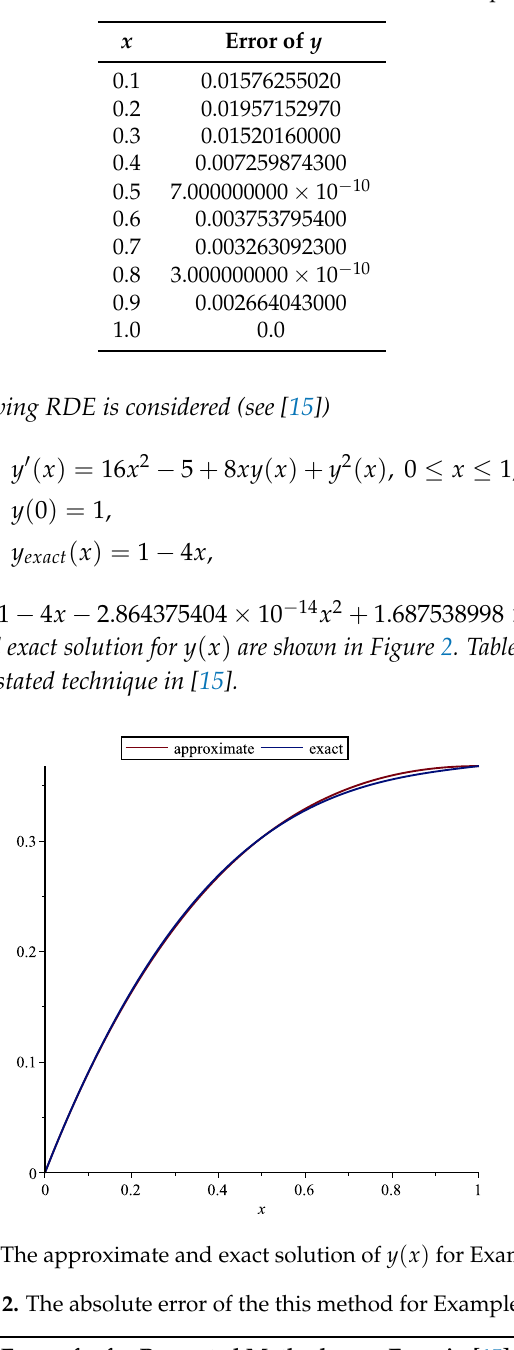
Table 1. The absolute error of the this method for Example 1.